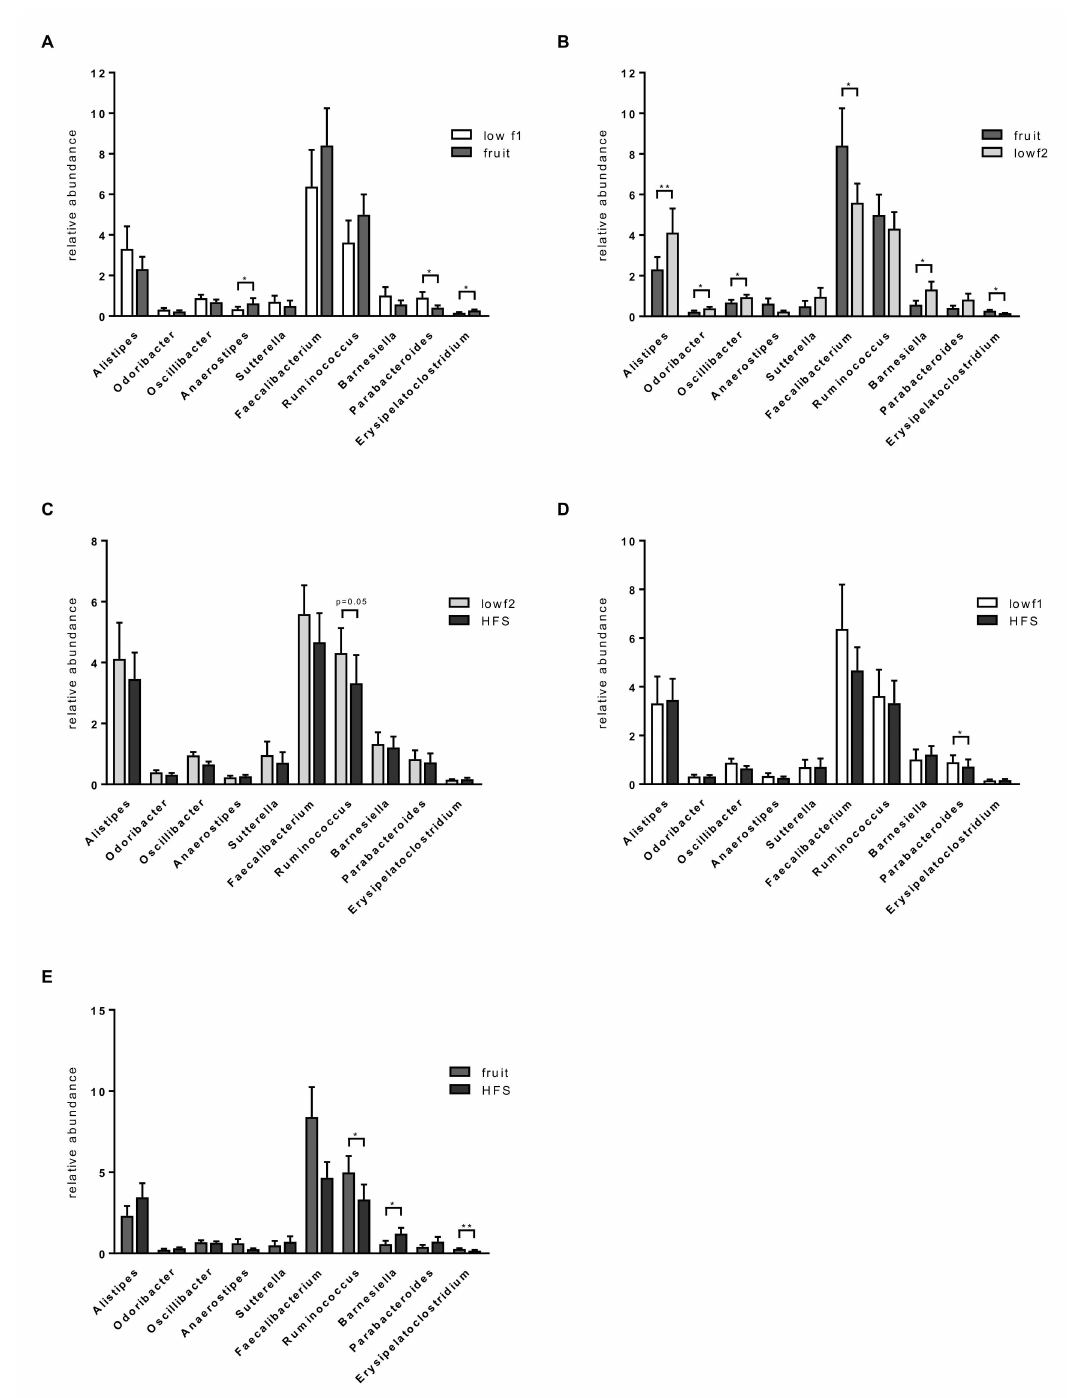
Figure 4. Changes of gut microbiota (relative abundances) on genus level among di ff erent fructose diets. ( A ) lowf1 vs. fruit, ( B ) fruit vs. lowf2, ( C ) lowf2 versus high-fructose syrup (HFS), ( D ) lowf1 vs. HFS, ( E ) fruit versus HFS. Significant di ff erences are indicated as * p -value < 0.05 and ** p -value <